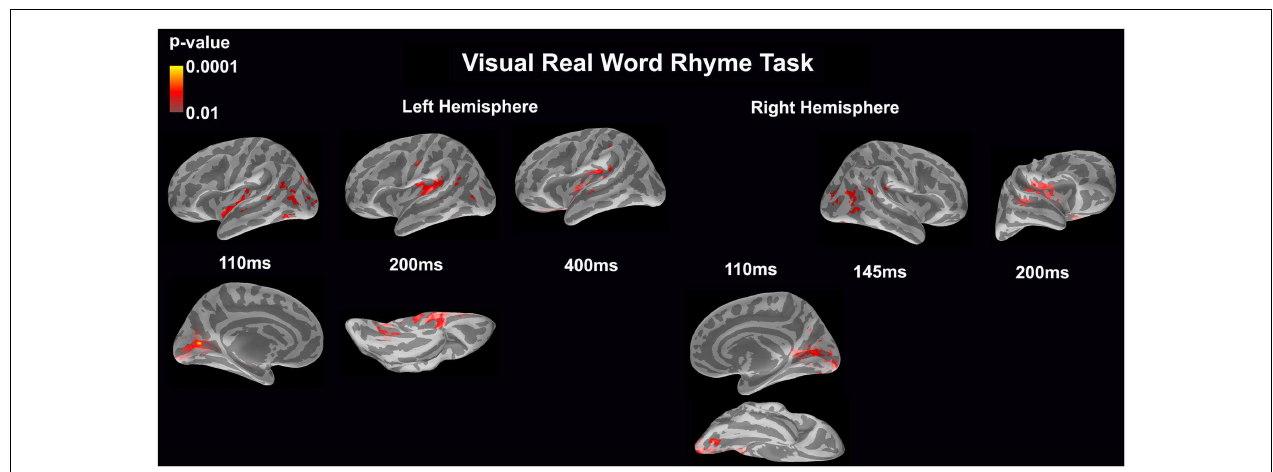
FIGURE 4 | Cortical activation during the visual real word rhyme task is shown . Dynamic statistical parameter maps represent cortical activation averaged across 15 children with epilepsy with times representing latency from the onset of the visual real word stimulus, which was centered on the screen in front of the participant.